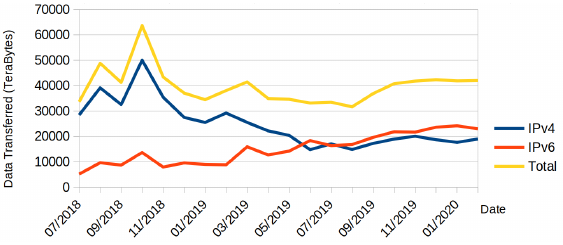
Figure 3. LHCOPN and LHCONE IPv4-IPv6 tra ffi c distribution as seen on the CERN